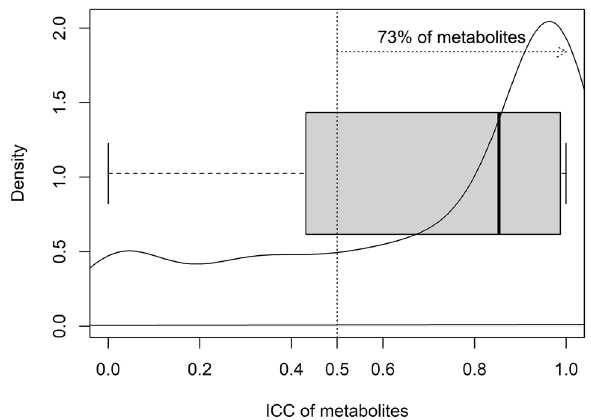
Figure 1. Distribution of temporal variability, measured by Intra-Class Correlation (ICC) of the 353 metabolites, identified as differentially abundant between the 4 collection time points [T1, T2, T4: 1, 2 and 4 min, respectively, after tying the tourniquet and NT (no tourniquet with sample collection 5 min after removal of the tourniquet)] in 05 study participants. The bold dark vertical line of the box-whisker plot superimposed on the density indicates the median ICC, the left and right sides of the rectangle are indicative of 25th and 75th percentiles and the whiskers measure the 95% confidence interval. The vertical dotted line at 0.50 ICC has been included to visualize the proportion of metabolites accounting for temporal variability > 50% of total variation of each